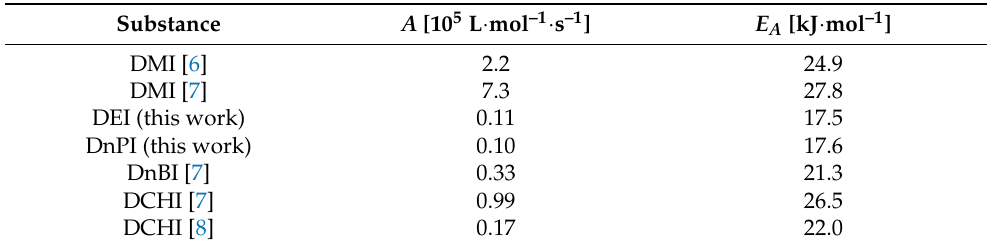
Table 6. Comparison of Arrhenius prefactors and activation energies for k p of different itaconic